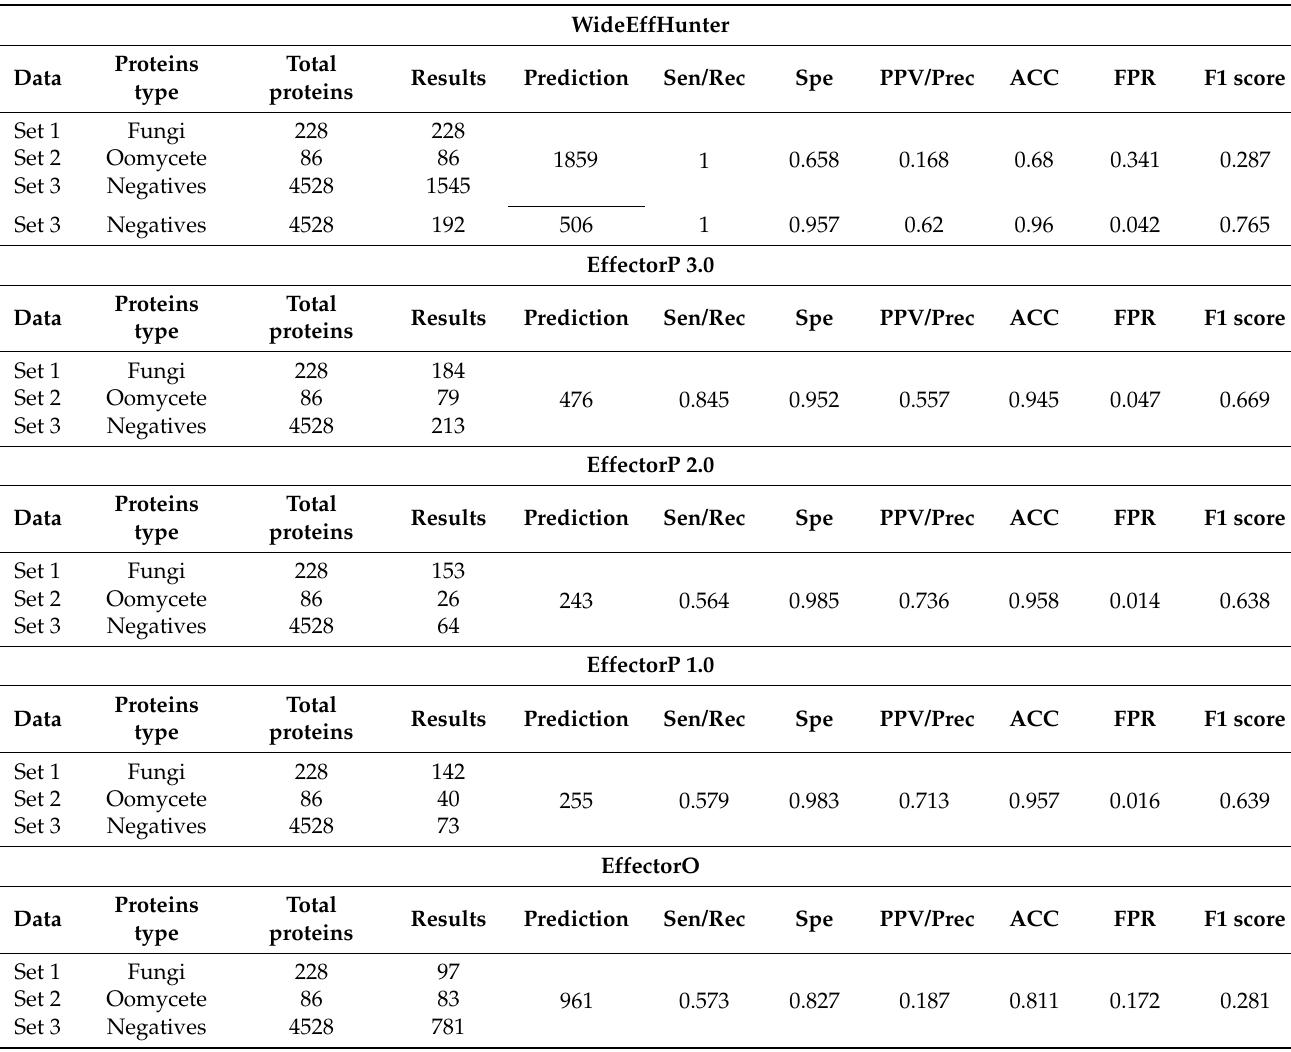
Table 7. Validation of WideEffHunter for prediction of fungal and oomycete effector proteins